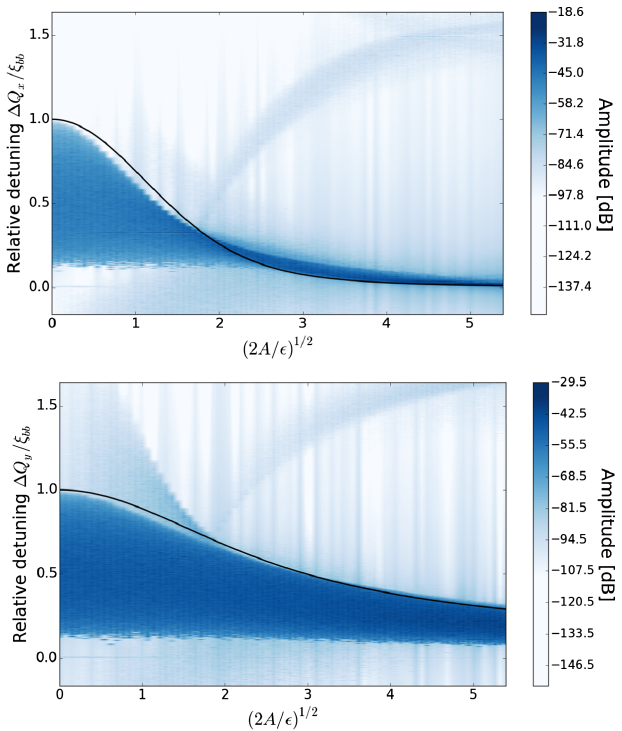
FIG. 3. Comparison of forced beam-beam amplitude detuning analytical formulas to simulations. Top: Direct amplitude detun- ing from Eq. (18). Bottom: Cross amplitude detuning from Eq. (19).